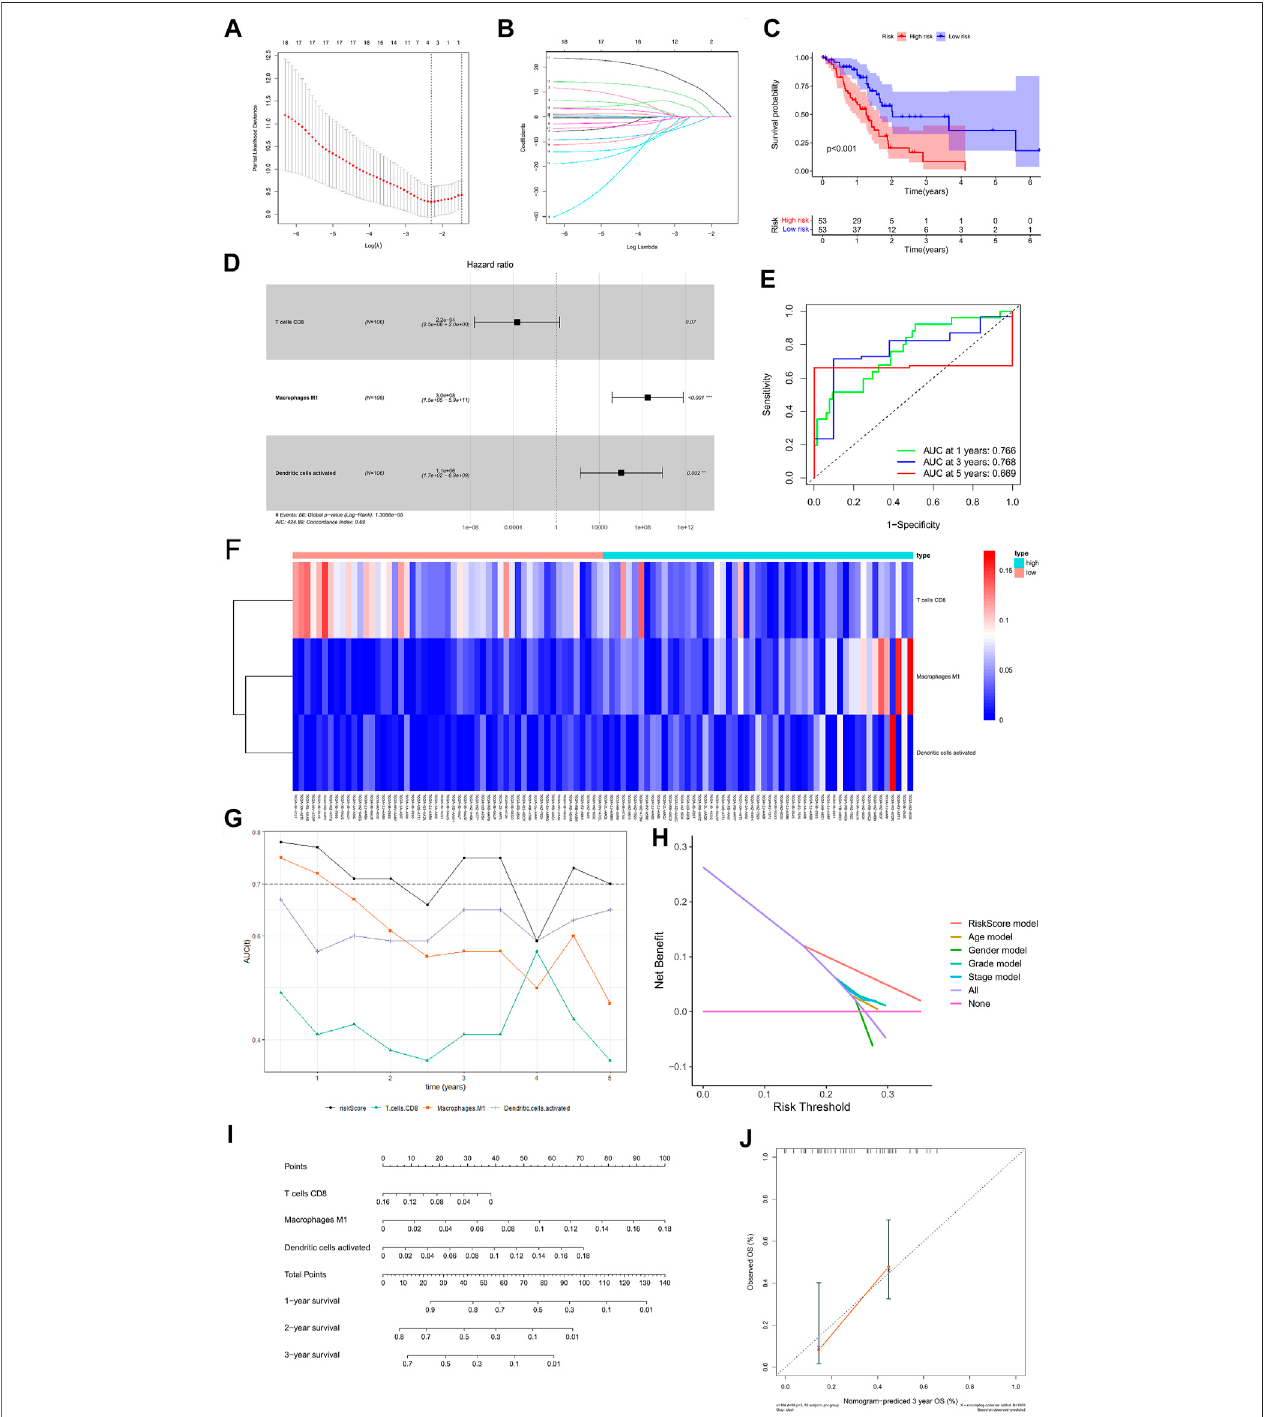
FIGURE 9 | Construction of the nomogram for predicting the survival probability of PAAD based on the prognostic-related immune cells. Results of Lasso regression (A, B) ; Kaplan – Meier survival curve in high- and low-risk groups based on the multivariate Cox regression analysis (C) ; forest plot of the multivariate Cox regression analysis (D) ;ROCcurvesofthemultivariateCoxmodel (E) ; heatmapofthethree immunecells intheCoxregressionmodel (F) ;areaunder themulti-indicator ROC curve (G) and decision-making curve (H) ; nomogram (I) ; nomogram-predicted probability of three-year overall survival (J) .